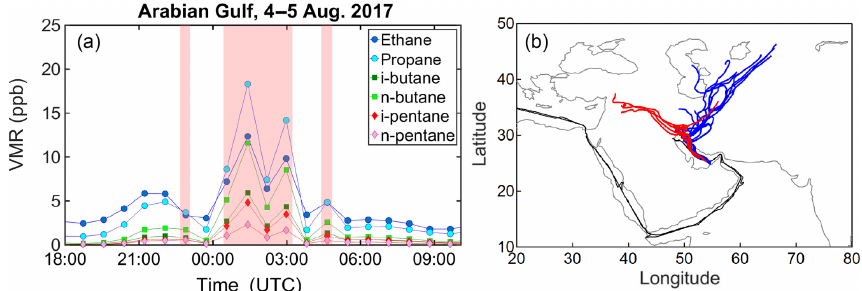
Figure 7. Time series of C 2 –C 5 alkane volume mixing ratios (a) and back-trajectories (a) of samples collected in the AG on 4–5 August 2017. In (b) the red trajectories correspond to the shaded red data points of (a) , while the blue trajectories correspond to all other samples. The back-trajectories start at the ship position and follow the air masses back in time for 6 days on an hourly time grid.